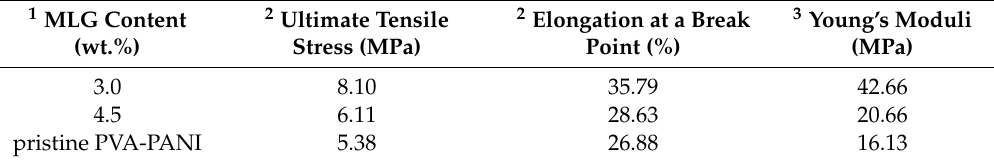
Table 4. Mechanical properties of PVA–PANI HDGs with di ff erent MLG